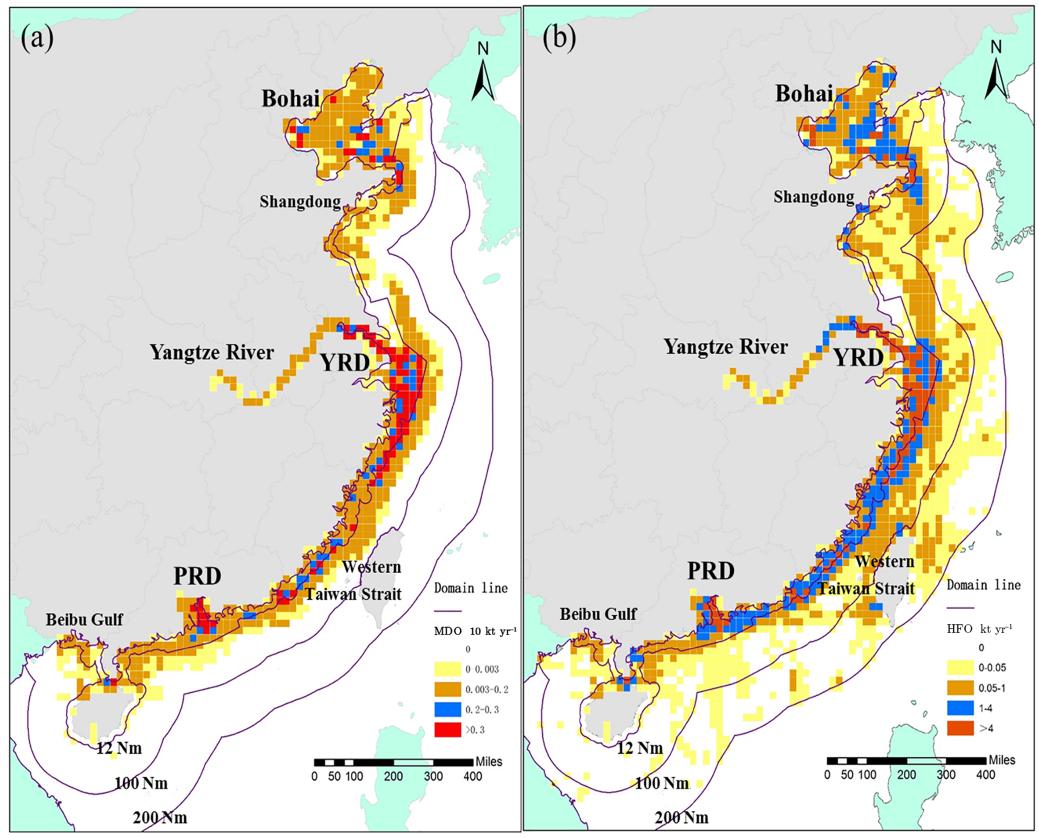
Figure 2. Spatial distribution of marine diesel oil MDO (a) and HFO (b) consumption by ships (27km × 27km). Table 10. Emission intensities in three DECAs and along typical navigation lines. DECA Topical transport line a Bohai